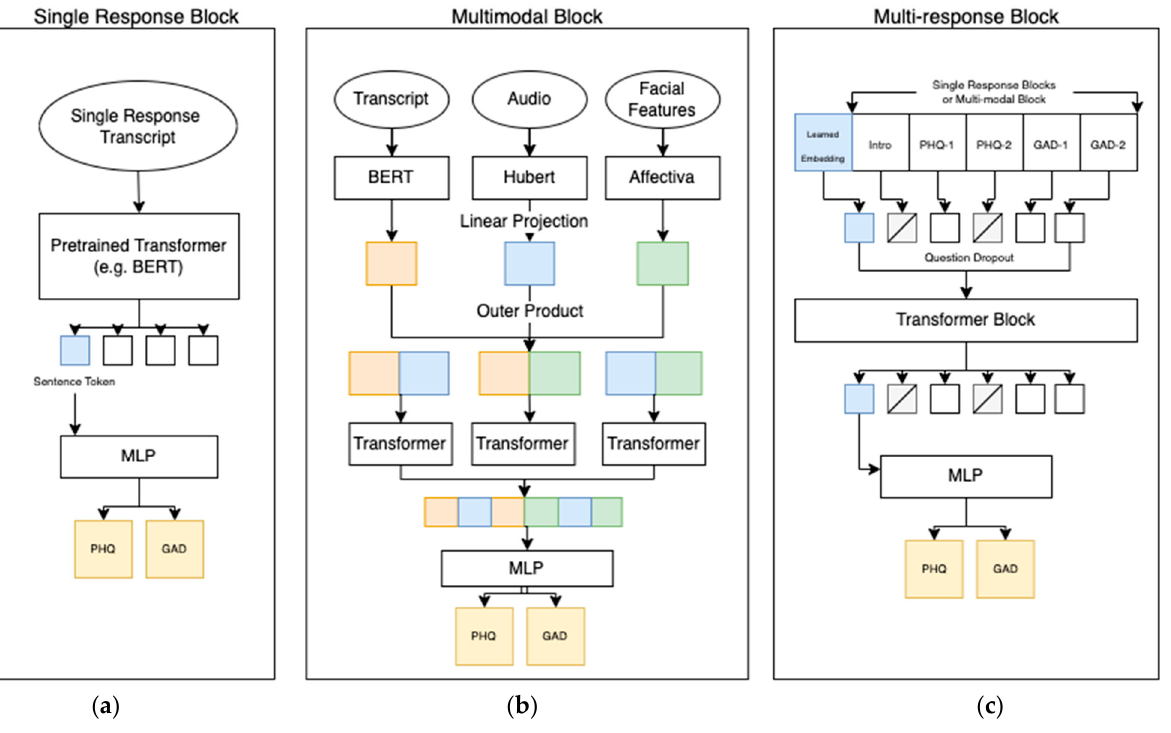
Figure 3. Model architecture of the final PHQ-V and GAD-V model consisting of three different parts: ( a ) A single response block which finely tuned a pre-trained transformer; ( b ) a multimodal block which combines multiple single response blocks using a self-attention transformer block; and ( c ) a multi-response block which combines multiple questions and uses a self-attention transformer combined with question dropout. The final PHQ/GAD layer shows that scores can be assessed at any of the three blocks, or the embeddings can be passed down to further blocks allowing comparison of scores at different levels of abstraction.